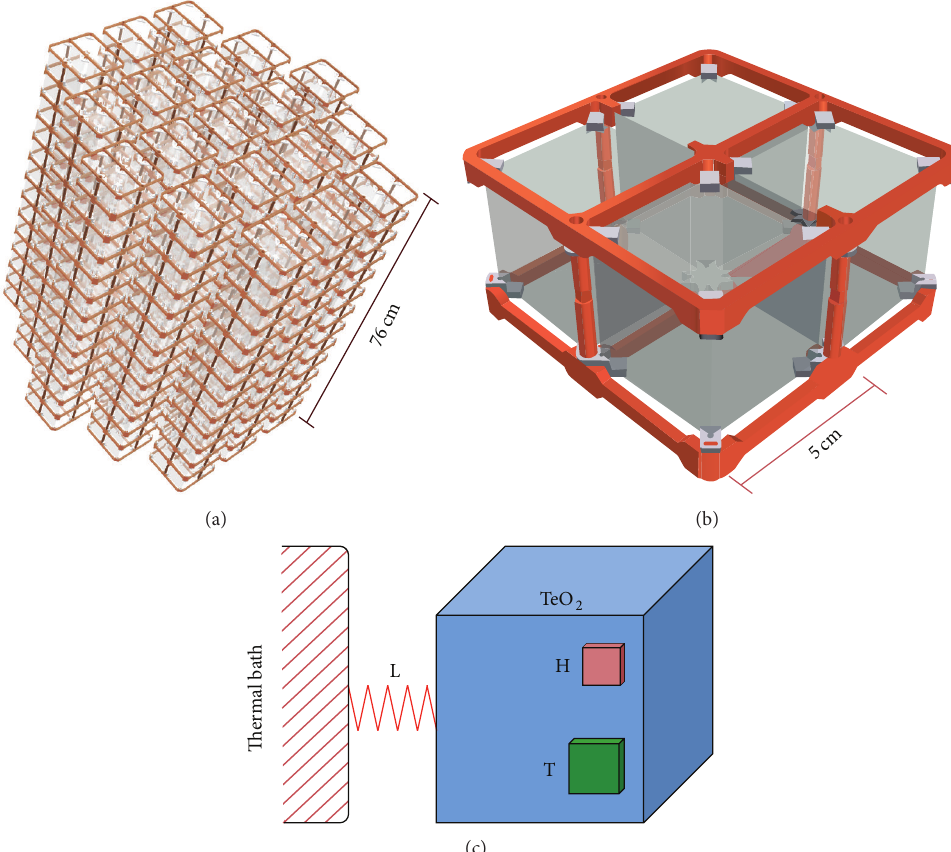
Figure 1: (a) Illustration of the planned 19-tower CUORE detector array. (b) Close-up of a single tower floor showing four TeO 2 crystals held inside their copper frame by PTFE spacers. (c) Schematic diagram of an individual TeO 2 crystal bolometer. Each crystal is instrumented with a heater (H) and a thermistor (T); the PTFE spacers and sensor readout wires act as weak thermal links (L) between the crystal and the thermal bath of the copper